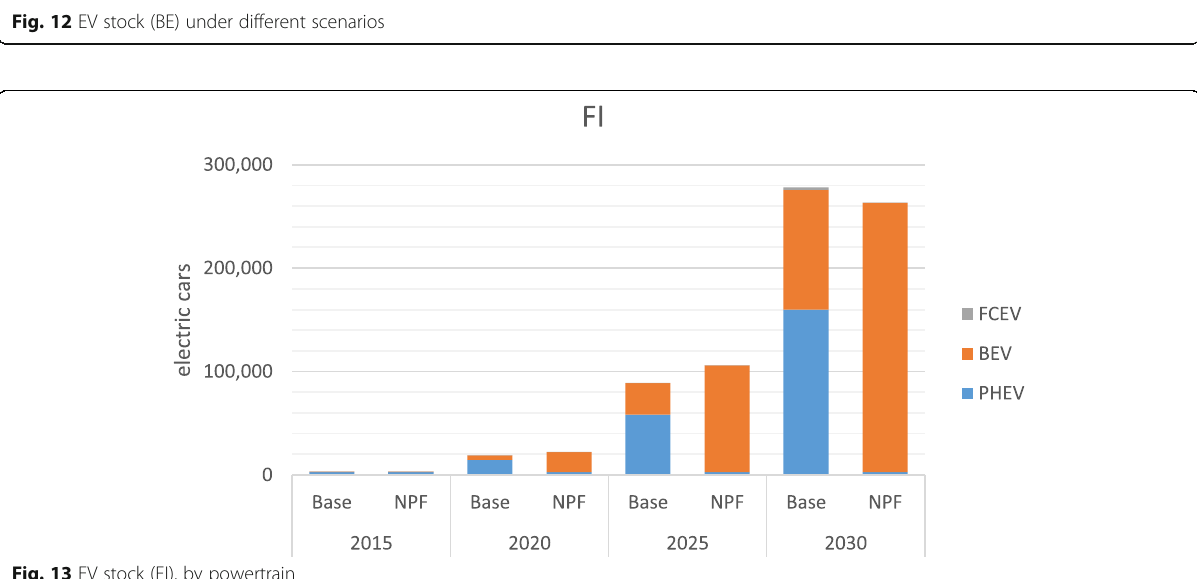
Fig. 12 EV stock (BE) under different scenarios